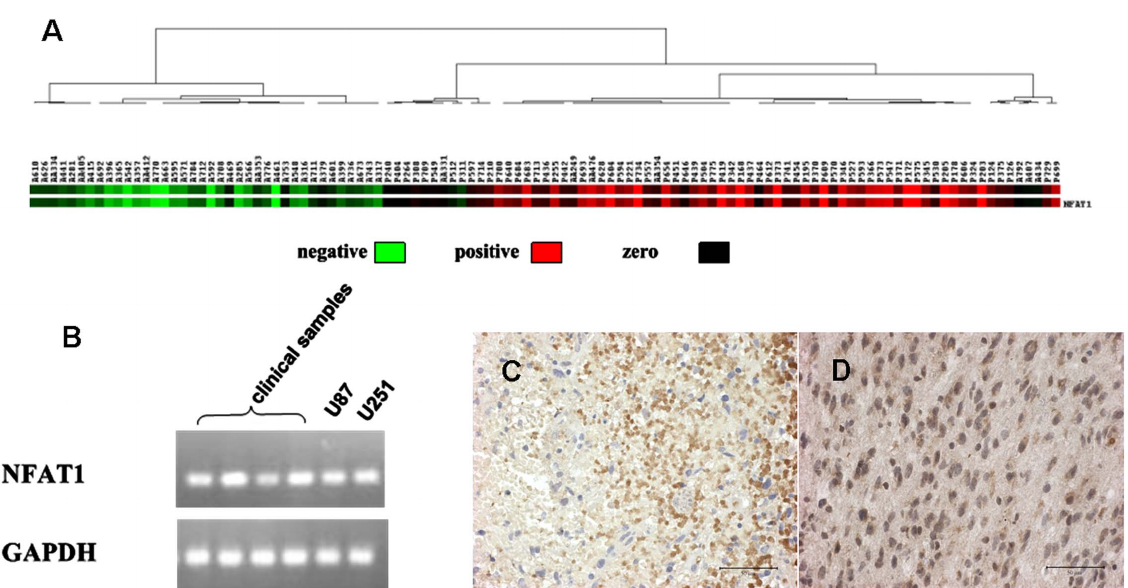
Figure 1. Expression of NFAT1 in glioma. A: The mRNA expression of NFAT1 obtained from microarray analysis in 111 clinical samples was analyzed by cluster analysis and visualized by Treeview software. Compared with low-grade glioma, NFAT1 was overexpressed in GBM. B: RT-PCR was used to examine the mRNA expression of NFAT1 in U87, U251 GBM cell lines and 24 clinical GBM samples. Confirming the result of microarray analysis, high expression of NFAT1 was detected in all the samples. C: NFAT1 expression and location examined by immunohistochemistry in GBM and astrocytoma (40 6 ). The deep brown NFAT1 staining was mainly located in the nuclei of GBM cells, and the cytoplasm of cells was also stained brown. D: Only a few astrocytoma cells stained light brown in the cytoplasm.